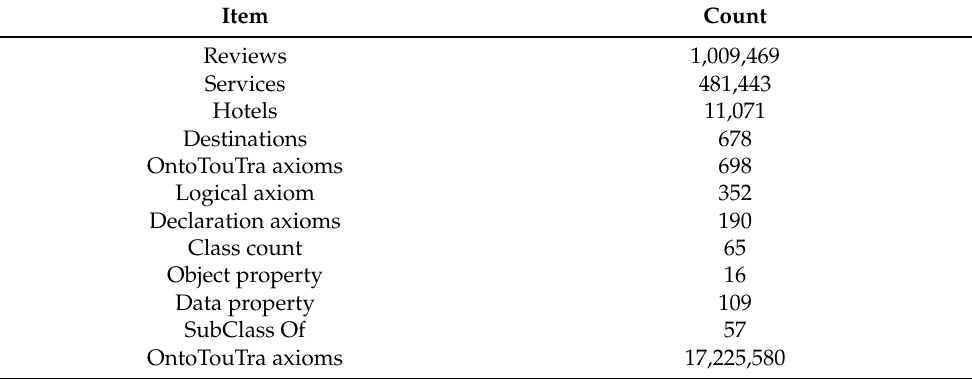
Table 7. OntoTouTra